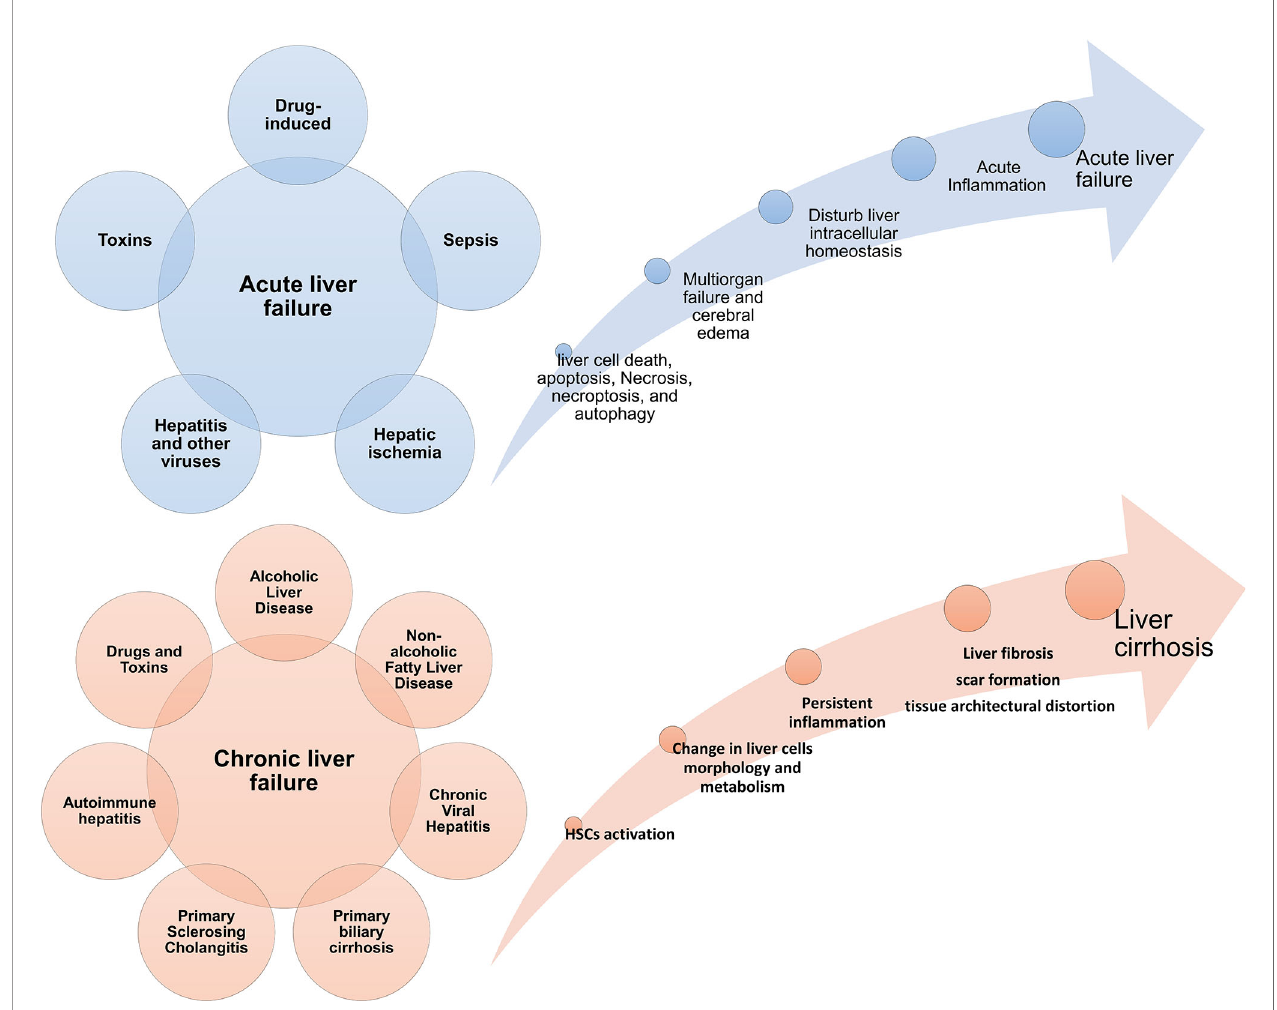
FIGURE 1 | Acute and chronic liver diseases. Diseases Different conditions can cause acute and chronic in fl ammatory conditions in the liver. If the damages are not controlled in the acute stage, they progress to a chronic state and are associated with fi brosis and cirrhosis of the liver tissue. Failure in acute liver disease treatment can also lead to the onset and progression of liver cancer; HSC, hepatic stellate